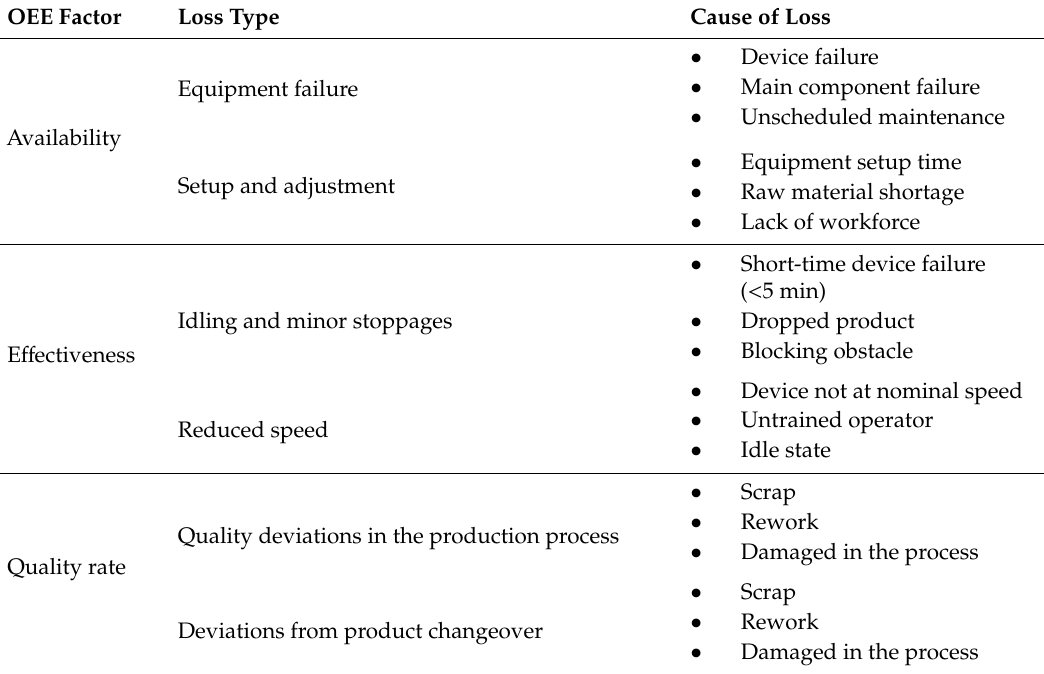
Table 3. Overall Equipment E ff ectiveness (OEE) factors combined with six loss types and possible causes of loss